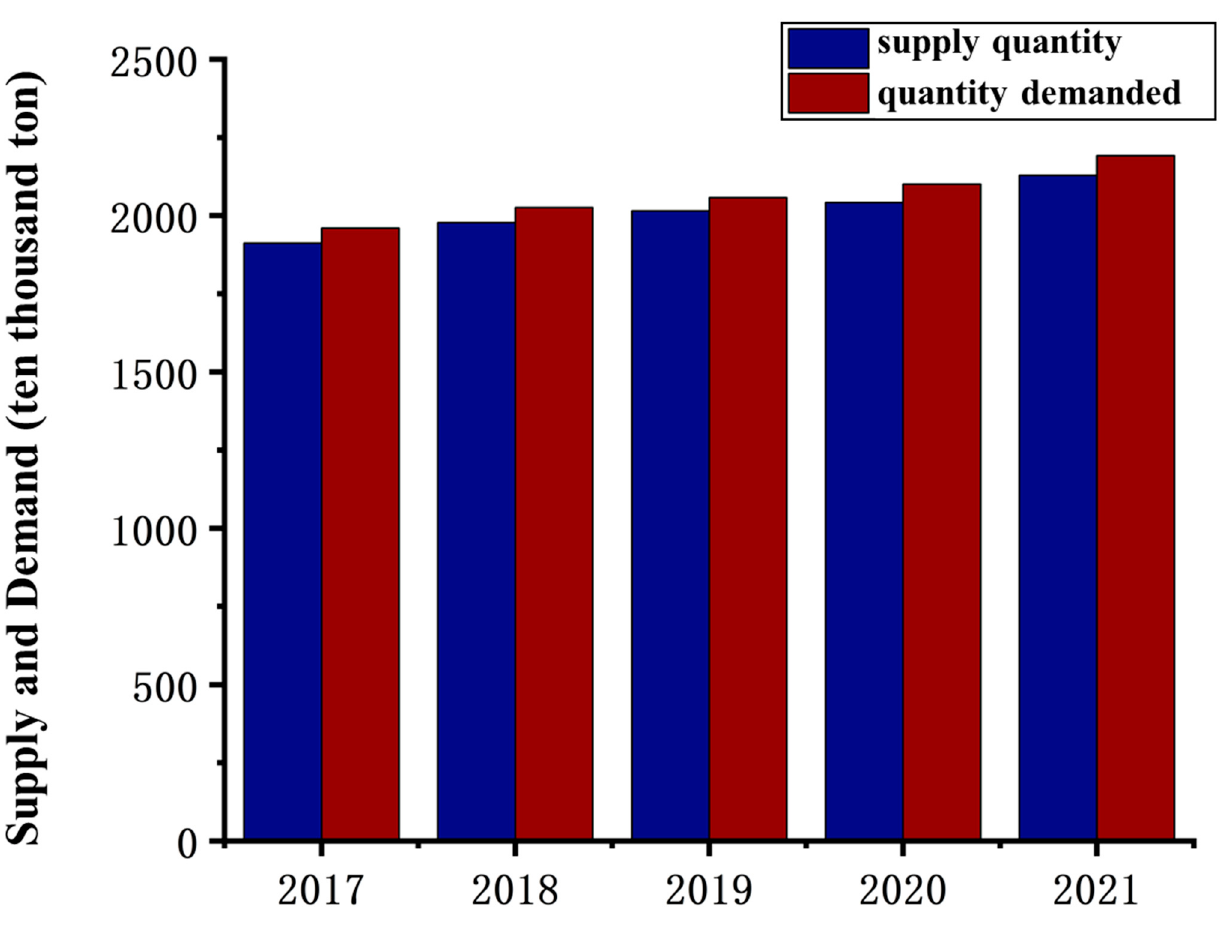
Figure 1. Hydrogen supply and demand balance in China’s hydrogen industry for the period of 2017–2021.